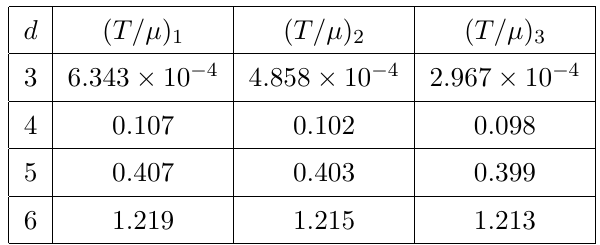
Figure 8. The ED, (cid:27) , in units of entropy density, s , versus LT for the strip in AdS-RN with d = 8, for T=(cid:22) = 5 down to 0 : 1.